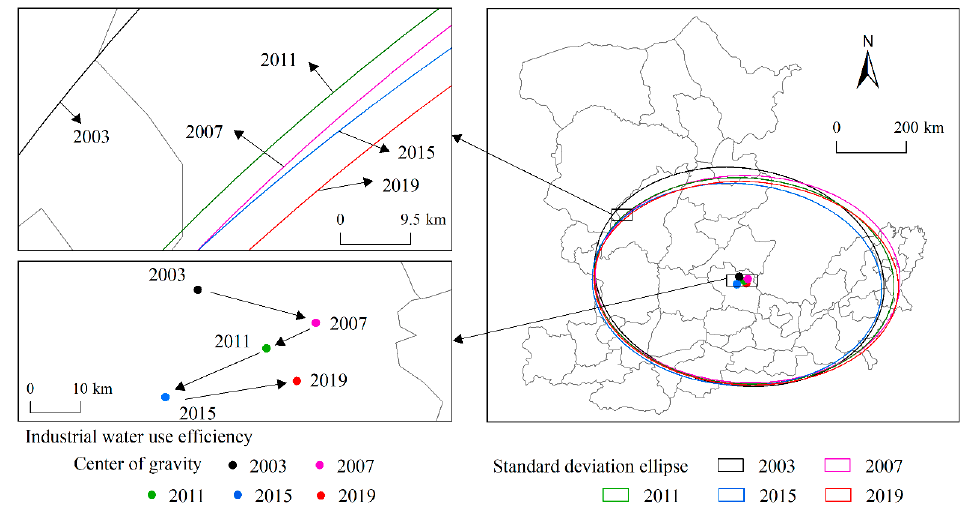
Figure 4. Trajectory of the center of gravity and standard deviation ellipse of industrial water efficiency.